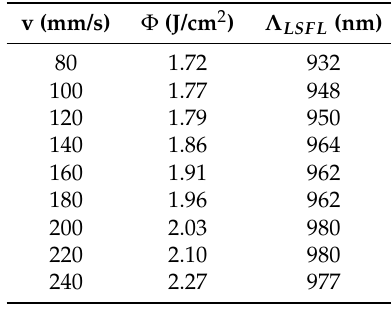
Table 1. Periodicities of the one-dimensional LSFL for different fluences and scanning speeds. Periodicities are determined via transferring the SEM pictures in the Fourier spectra.